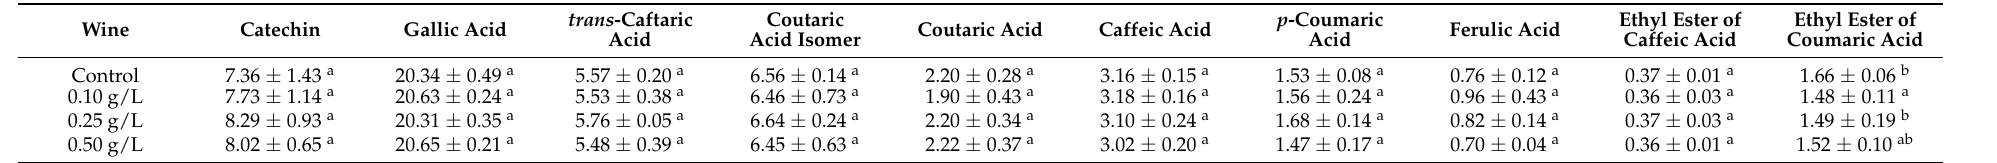
Table 4. Phenolic acid profile and flavonoids in mg/L of red wines after applying different doses of ADSI cork powder (0.10, 0.25, and 0.50 g/L).